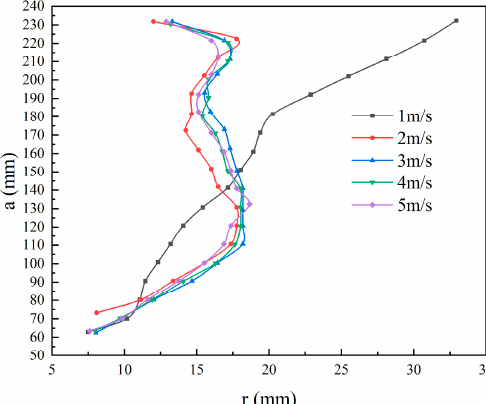
Figure 9. LZVV diagram.